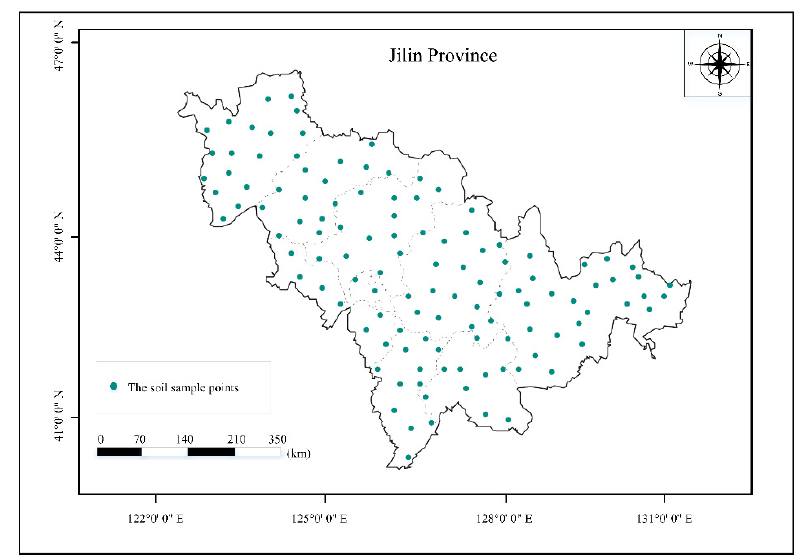
Figure 1. Study area and sampling